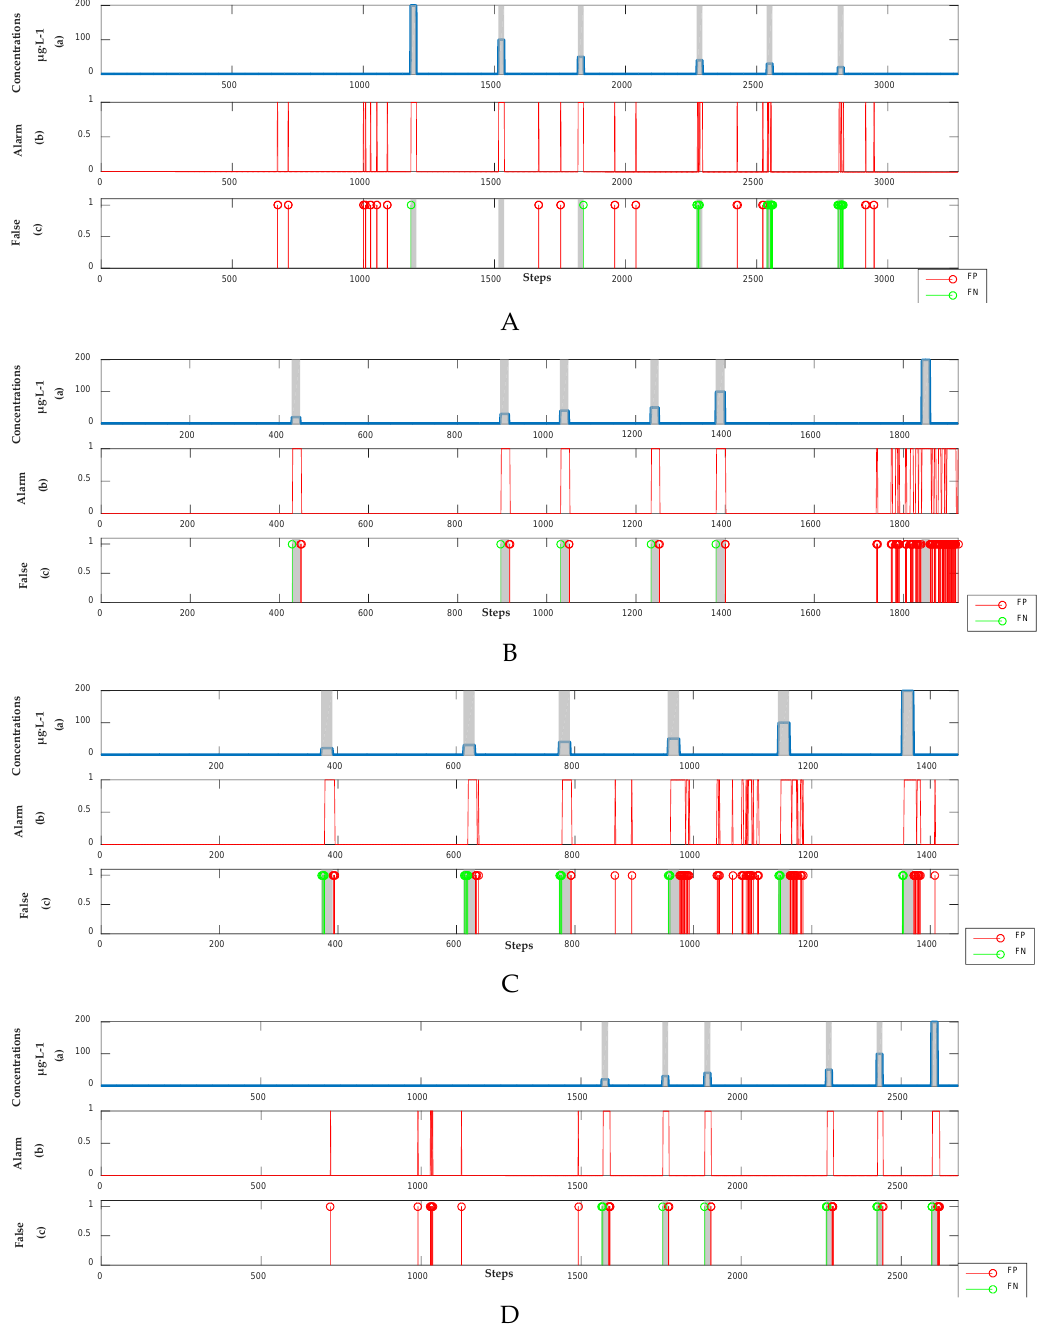
Figure 8. Detection results of the supervised model. (Panel ( A )) The concentrations, alarm signals and FP points and FN points of phenol; (Panel ( B )) The concentrations, alarm signals and FP points and FN points of m-phenylenediamine; (Panel ( C )) The concentrations, alarm signals and FP points and FN points of hydroquinone; (Panel ( D )) The concentrations, alarm signals and FP points and FN points of resorcinol.